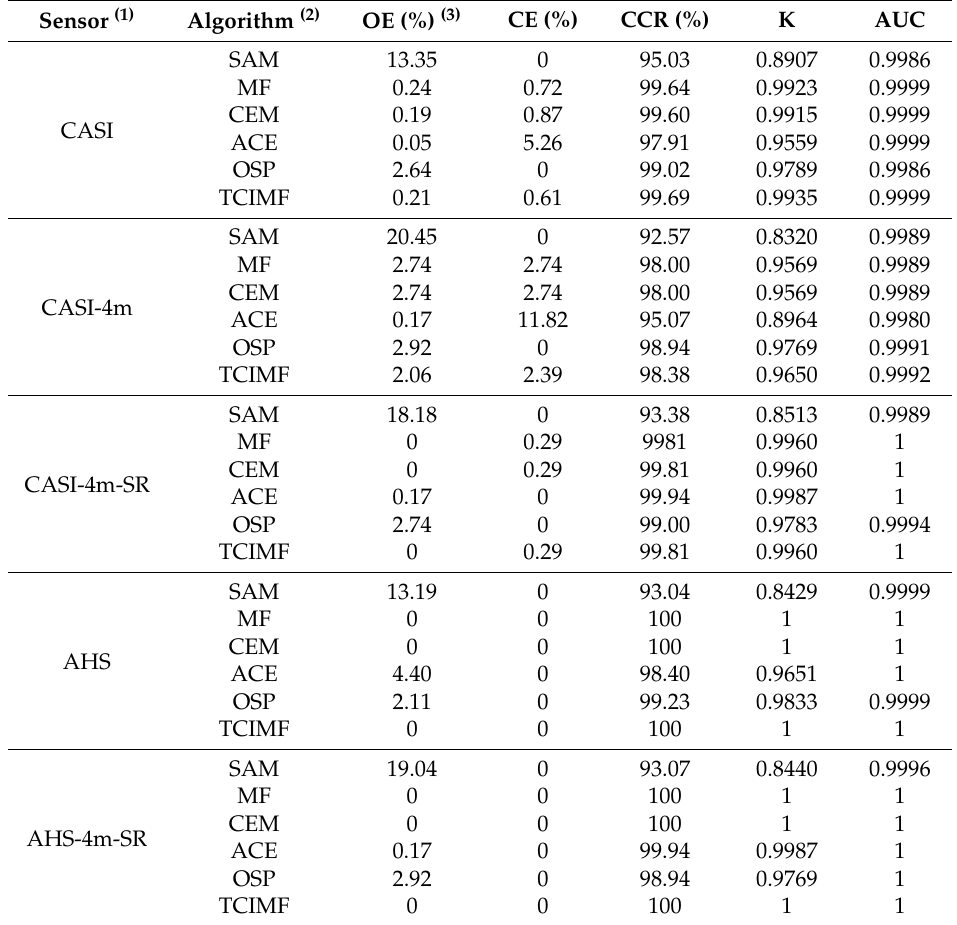
Table 5. Validation of the prediction of the spectral detection algorithms using the test polygons in each hyperspectral